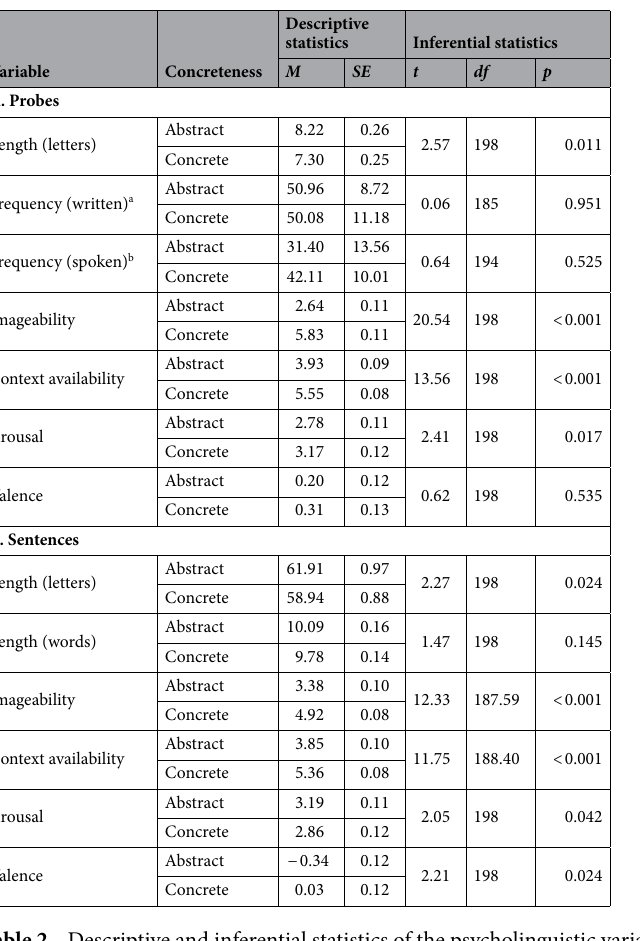
Table 2. Descriptive and inferential statistics of the psycholinguistic variables for the probe words (A) and cue sentences (B) used in Experiment 1 . Imageability, Context Availability and Arousal were rated on 1–7 Likert scales, Valence on a scale from − 3 to + 3. Independent samples t -tests compared the psycholinguistic variables for concrete and abstract words. n = 100 per condition, except for frequency (written: n concrete = 95, n abstract = 92; spoken: n concrete = 99, n abstract = 97). M mean, SE standard error, df degrees of freedom. a Frequency of occurrence of Mannheim Lemmas in 1 Mio. words, based on the CELEX database 40 . b Frequency of occurrence of case- insensitive lemmas based on the SUBTLEX-DE database 41 .